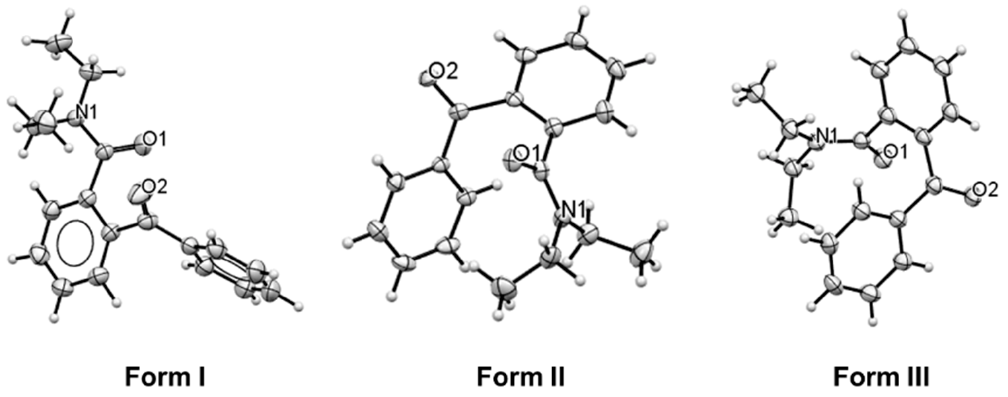
Figure 1. Contents of the asymmetric unit of forms I–III of BDB.